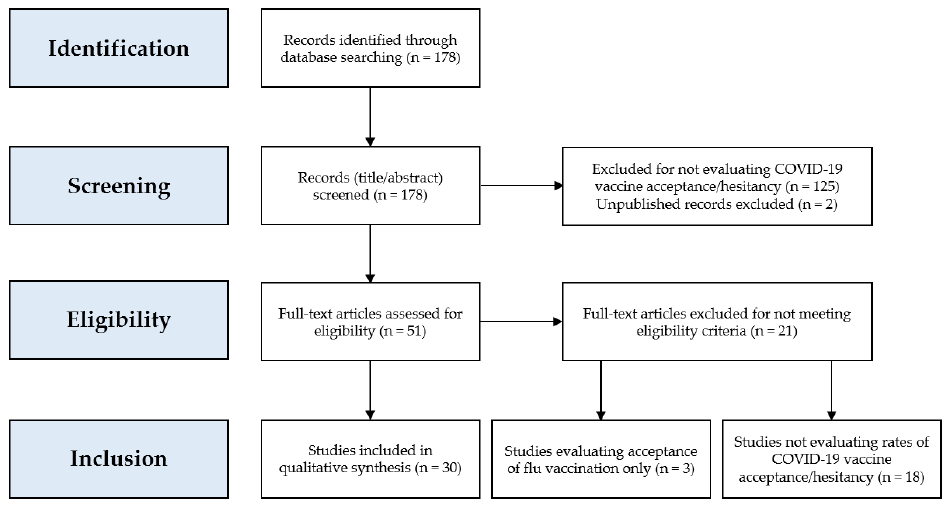
Figure 1. Flow chart of the study selection